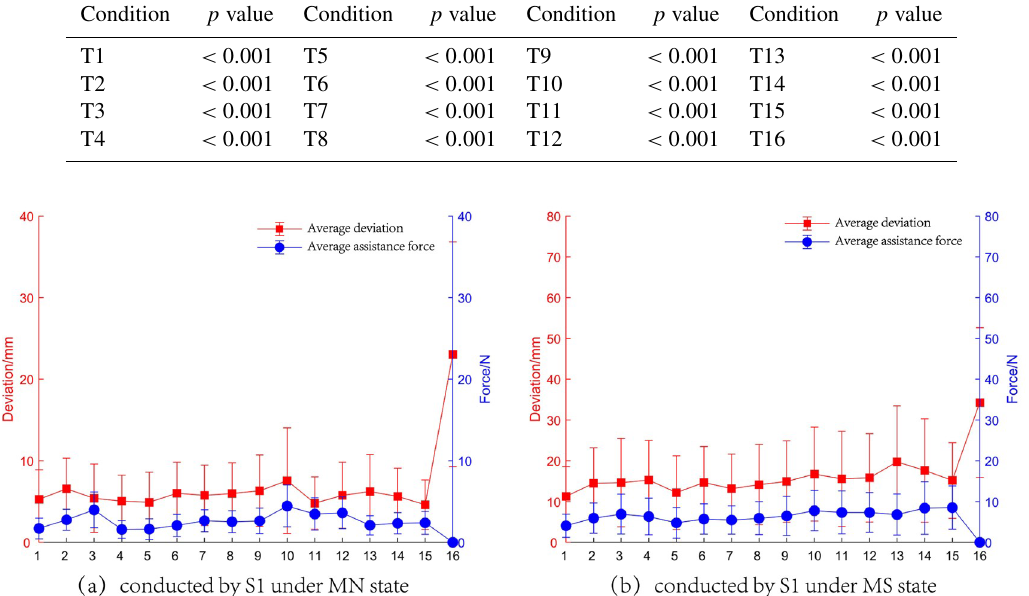
Figure 9. The experimental results of the tests conducted by S 1 , showing (a) the average assistance force and deviation obtained in the MN state and (b) the average assistance force and deviation obtained in the MS